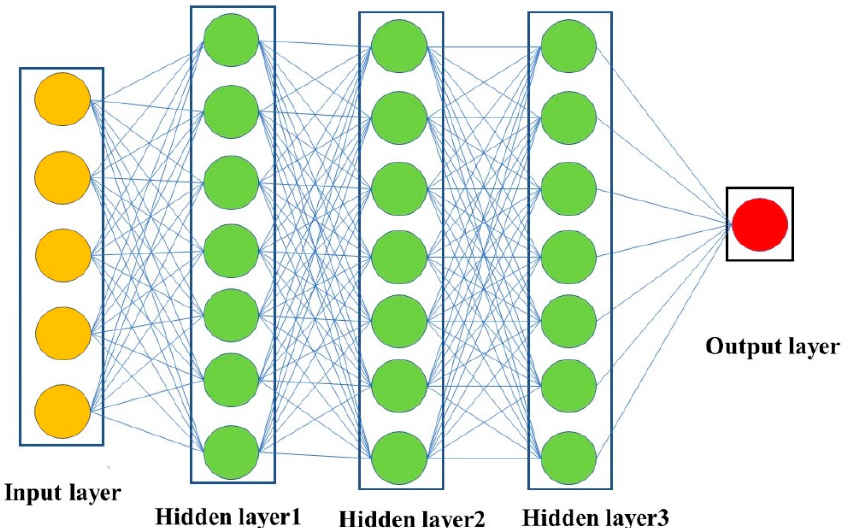
Figure 5. Architecture of ANN with 5/50/50/50/1 nodes used in optimal hybrid model .